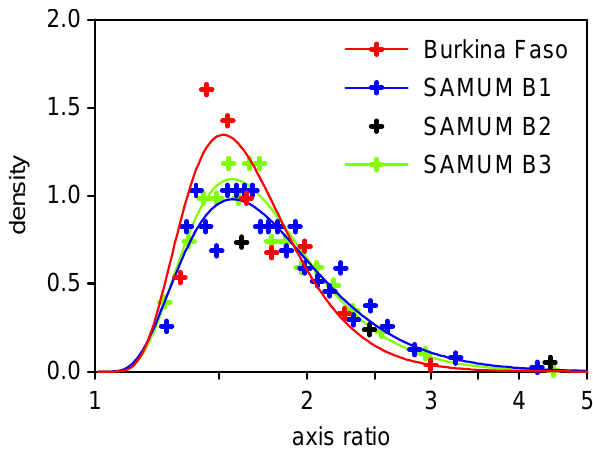
Fig. 6. Ellipse axis ratio density distributions for the soil-generated aerosol samples. The solid lines are modified log-normal functions fitted to the data. For the function description refer to Kandler et al. (2007). SAMUM B2 did not yield enough particle counts for a parameterisation.